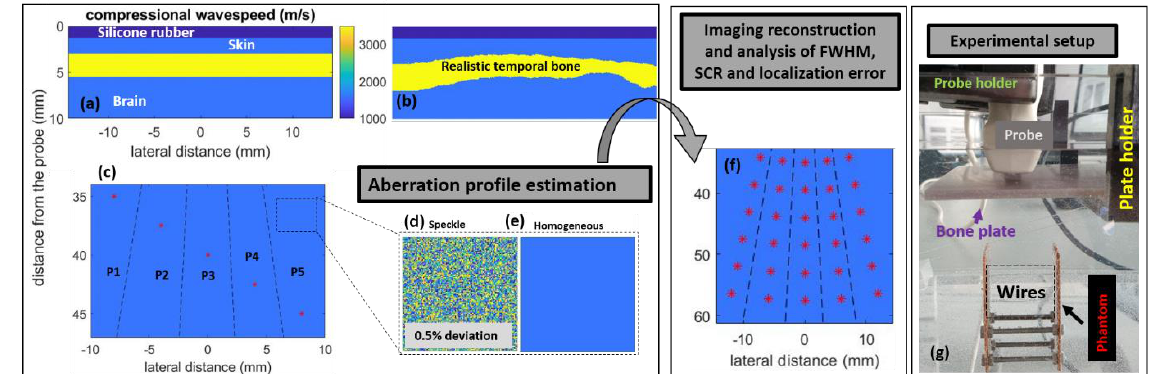
Figure 3. ( a , b ) The layered medium used in the simulation with a flat bone layer or a realistic temporal bone. ( c ) The numerical phantom used for estimating the aberration profile in each isoplanatic patch (P1–P5); the dashed lines separate isoplanatic patches. ( d ) The heterogeneous and ( e ) homogeneous background wave-speed model used in the simulations conducted for aberration profile estimation. ( f ) The numerical phantom used to generate the dataset needed for analysis of the full-width at half-maximum (FWHM), the signal-to-clutter ratio (SCR), and localization error. ( g ) The experimental setup to image a wire phantom while a bone mimicking plate is positioned in front of a phased array.